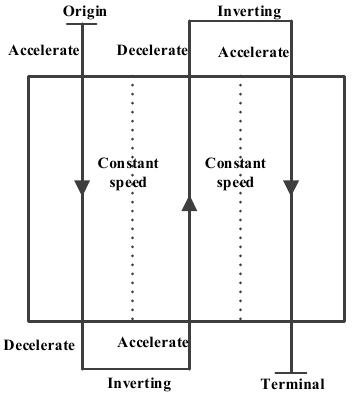
Figure 4. Schematic diagram of movement path of profilometer.